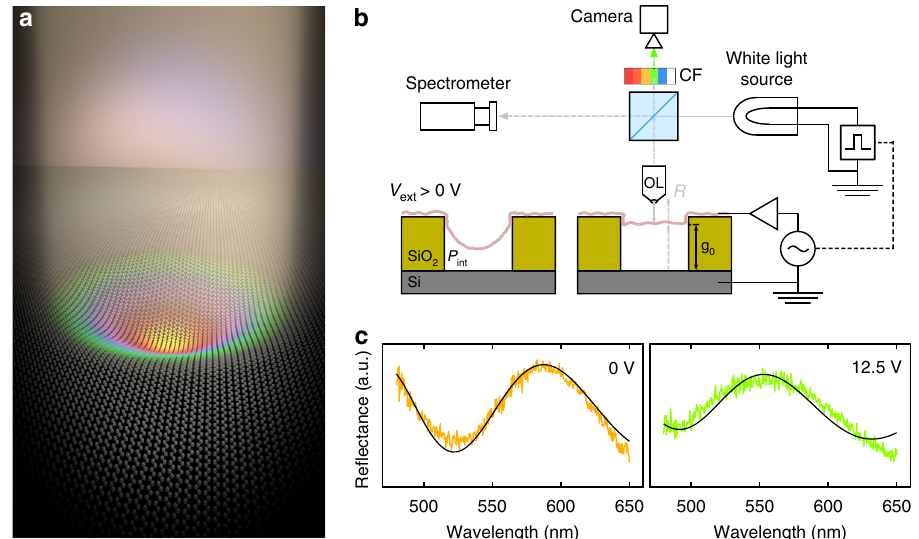
Fig. 1 Electro-optical measurements with a colorimetry setup of a graphene drumhead of 20 μ m in diameter. a Artist impression of a deformed CVD DLG drumhead showing Newton ’ s rings upon white light illumination. b The membrane can be actuated electrostatically while its re fl ectance spectrum is measured with a spectrometer and a calibrated camera. The white light source is either a halogen lamp (for spectral studies) or a white LED synchronized to the membrane electrical control (for stroboscopic studies). c At different voltages, the re fl ectance spectrum peak of the overall membrane shifts from 580 nm to 510 nm in a controlled and reproducible manner. Black lines are the theoretical spectral re fl ectance obtained from Eq.